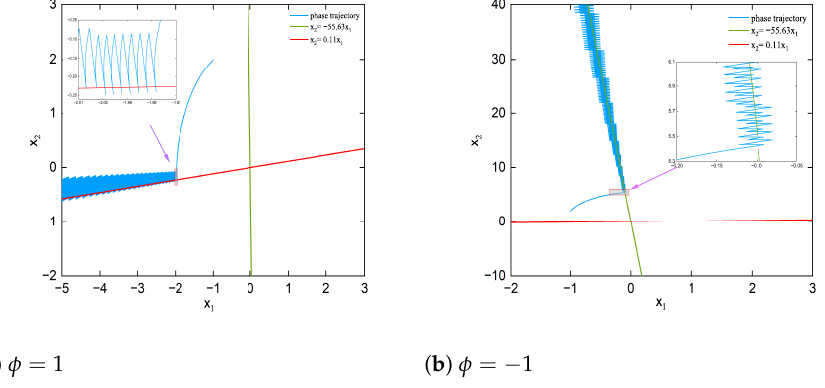
Figure 4. Phase diagrams and critical switching